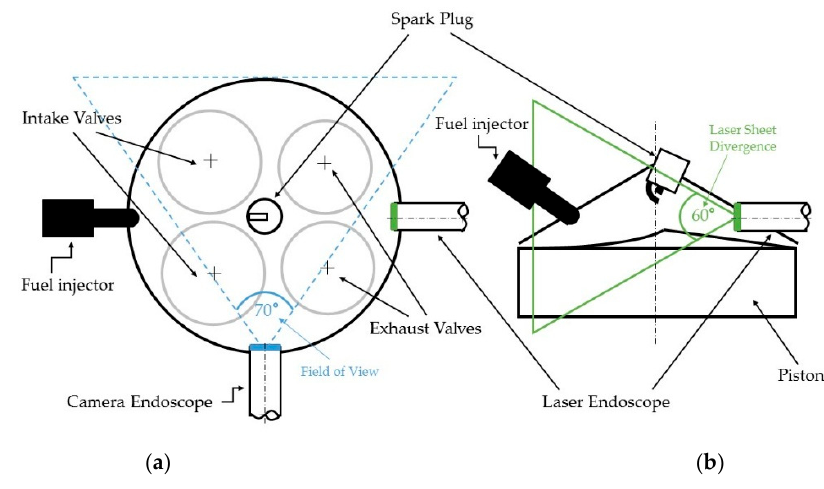
Figure 2. Optical measurement setup layout: ( a ) top view; ( b ) side view.